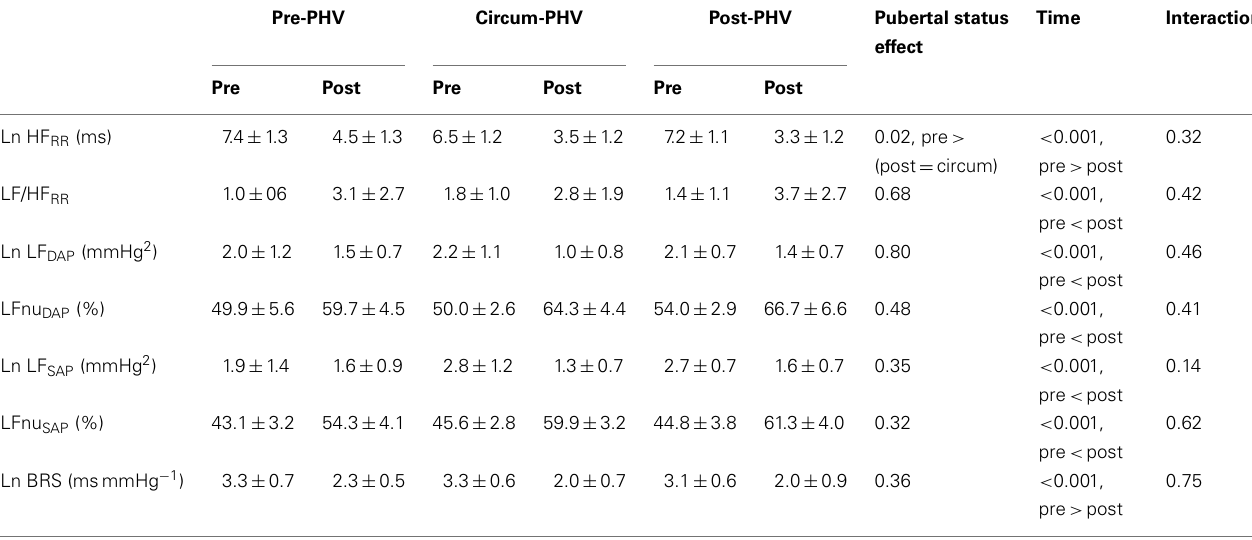
Table 4 |Autonomic measures before and after maximal incremental exercise in highly trained young soccer players classified according to maturity status.